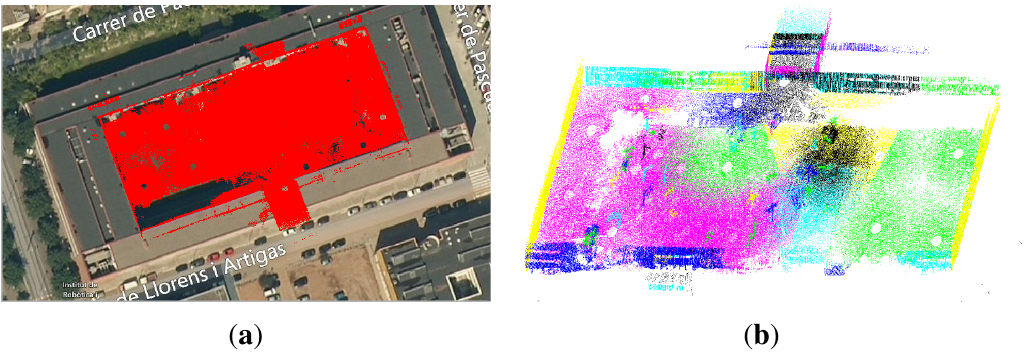
Figure 8. The Facultat de Matemàtiques i Estadística (FME) scenario. ( a ) The point cloud registered onto an aerial view of the scene; and ( b ) the segmented point